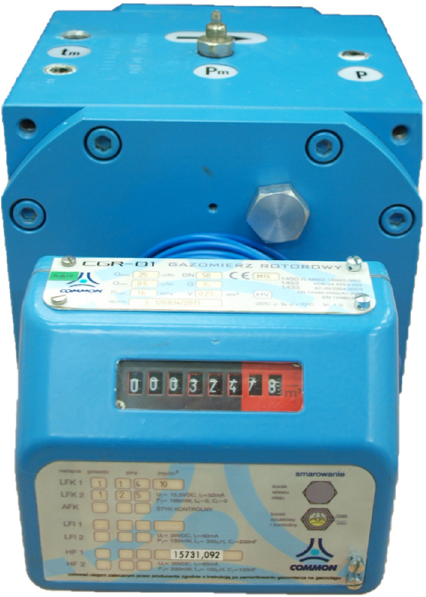
Figure 4. Reference gas meter.